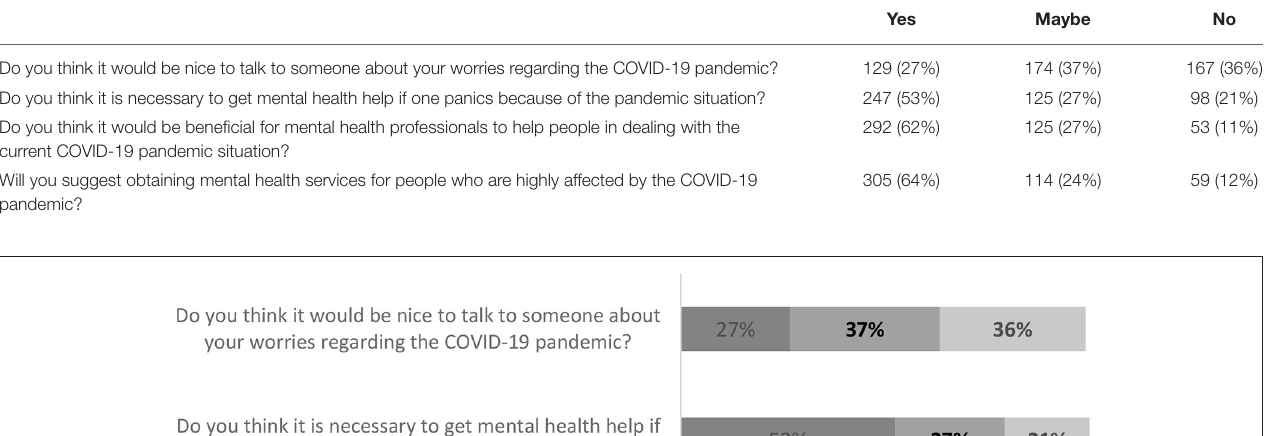
TABLE 7 | Perceived mental healthcare needs among participants.